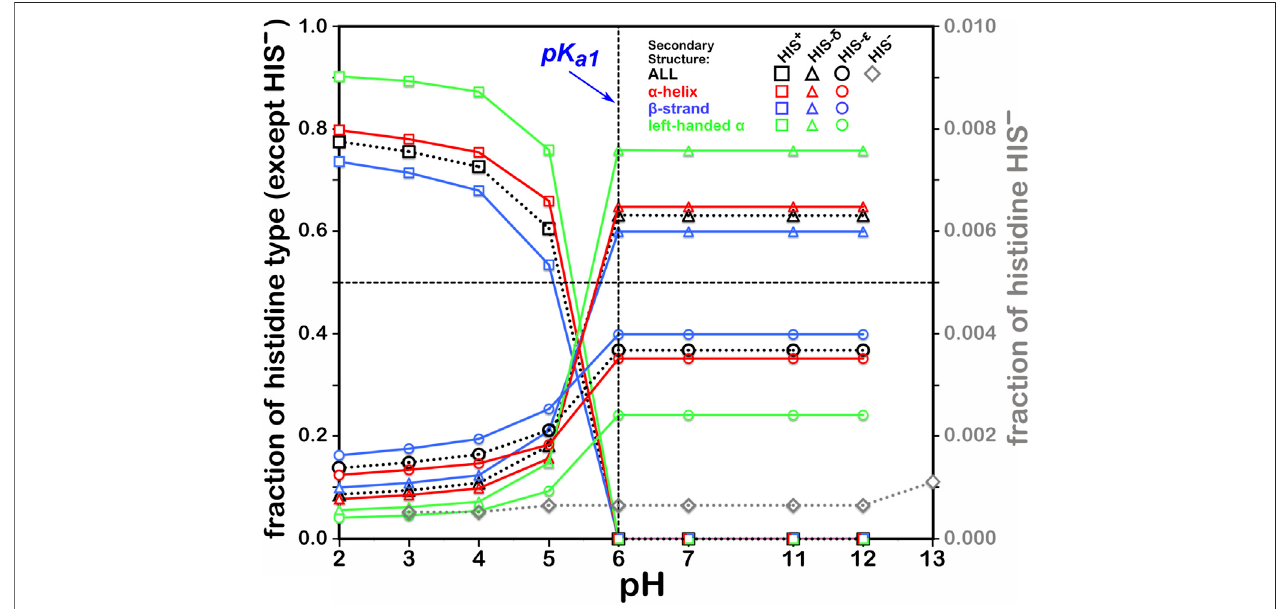
FIGURE 6 | Titration curves of HIS residues by secondary structure. The native pK a1 for histidine is indicated. Full deprotonation of HIS to HIS − is shown with data colored in gray and right-hand y-axis.